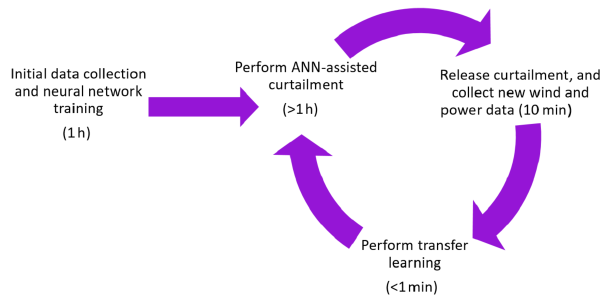
Figure 1. Flow diagram of the model-free approach to estimating available